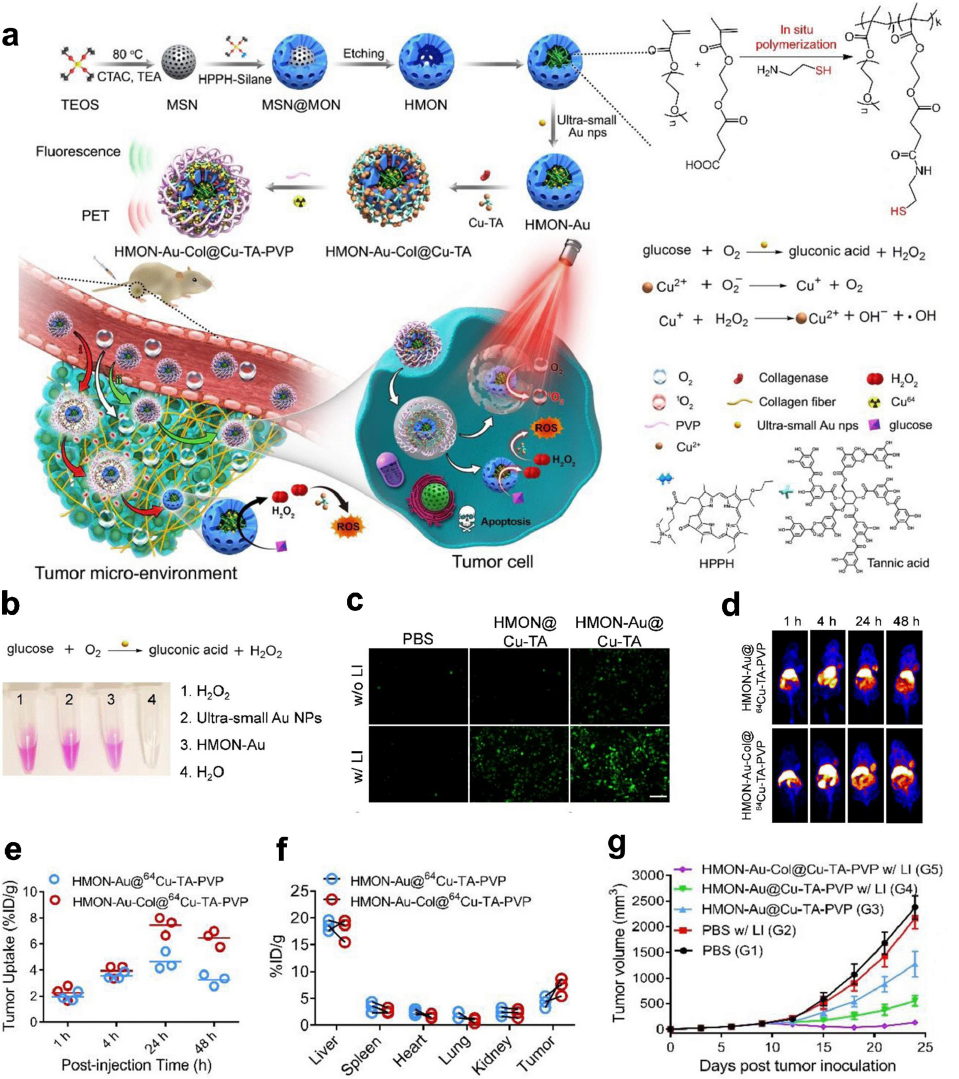
Figure 7. HMONs-Au-Col@64Cu-TA-PVP for PET. ( a ) Schematic showing the process of preparing the in situ polymerized hollow mesoporous organosilica biocatalytic nanoreactor for synergistic PDT/CDT. ( b ) Detection of H 2 O 2 production after the indicated treatment detected with a hydrogen peroxide assay kit. ( c ) Fluorescence images of ROS generation by BxPC-3 cells after the indicated treatment in the culture medium with glucose. ( d ) Representative in vivo PET imaging of tumor- bearing mice. ( e ) Quantification of HMON-Au@ 64 Cu-TA-PVP and HMON-Au-Col@ 64 Cu-TA-PVP tumor uptake. ( f ) Quantification of the PET signal intensities in the main organs of tumor-bearing mice. ( g ) The average tumor growth curves after treatment. Reproduced with permission from Ref. [111]. Copyright © 2019 WILEY-VCH Verlag GmbH & Co. KGaA, Weinheim.